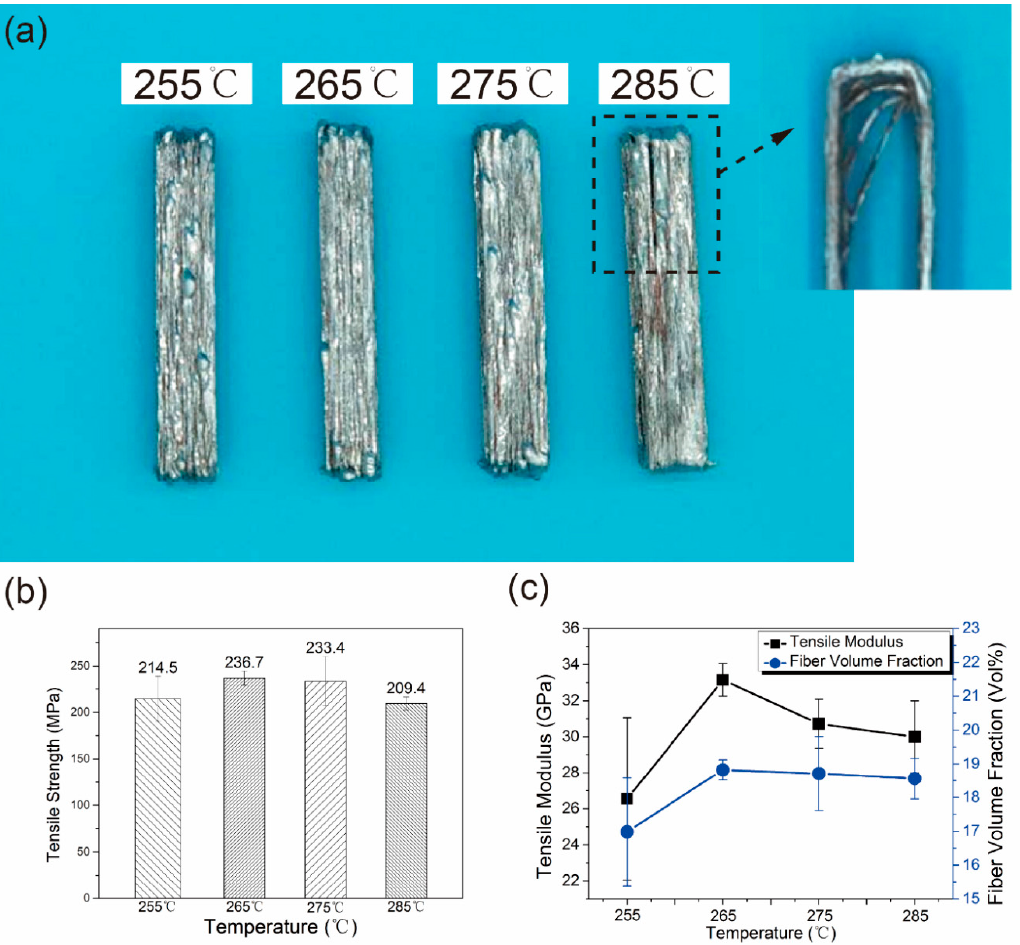
Figure 3. ( a ) Images of the composite structures printed at 255 °C, 265 °C, 275 °C and 285 °C observed with optical camera; ( b ) Ultimate tensile strength of the composite specimens S255, S265, S275 and S285. ( c ) Tensile modulus and fiber volume fraction of the composite specimens S255, S265, S275 and S285.